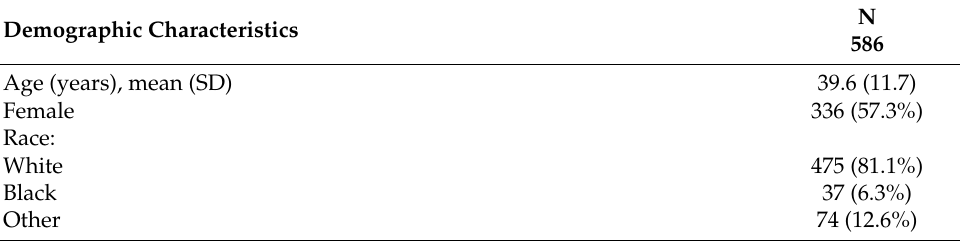
Table 1. Demographic Characteristics and Responses to Climate Change Items from 586 Participants who completed the MTurk Surveys at Waves 1 and